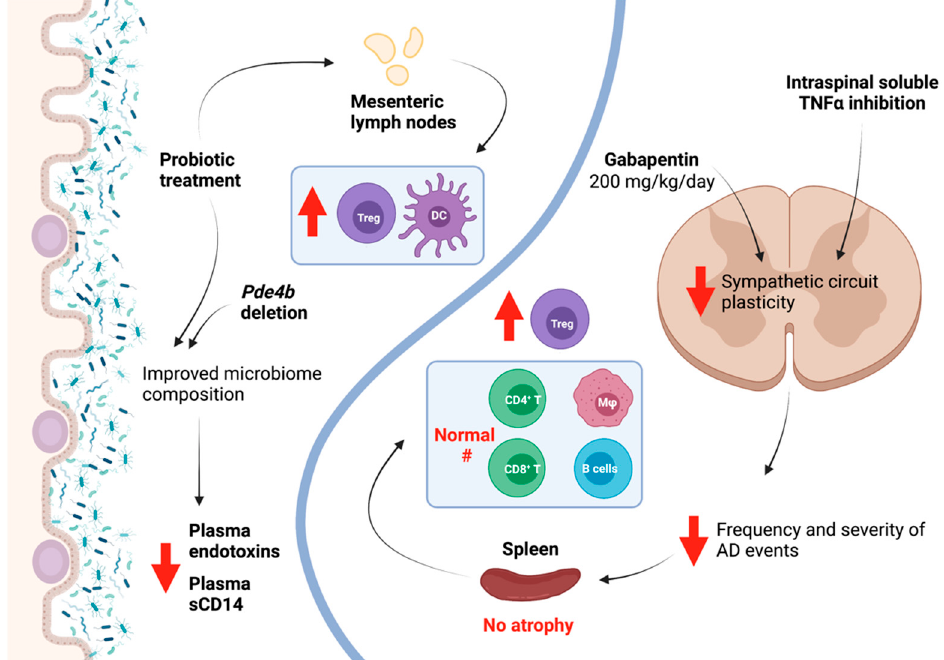
Figure 3. Preclinical studies have revealed that pharmacological inhibition of sympathetic circuit plasticity, either through the use of high-dose gabapentin (GBP) or soluble TNF α inhibition, can reduce autonomic dysreflexia (AD) and improve splenic immune cell profile. Separately, studies have examined the modulation of gut microbiota, either through probiotic treatment or deletion of Pde4b , to improve microbiome composition after SCI, which in turn improves anti-inflammatory immune cell profile in gut-associated lymphoid tissues (GALTs), like mesenteric lymph nodes (MLNs), and reduces circulating markers of inflammation. Created using BioRender.com accessed on 2 September